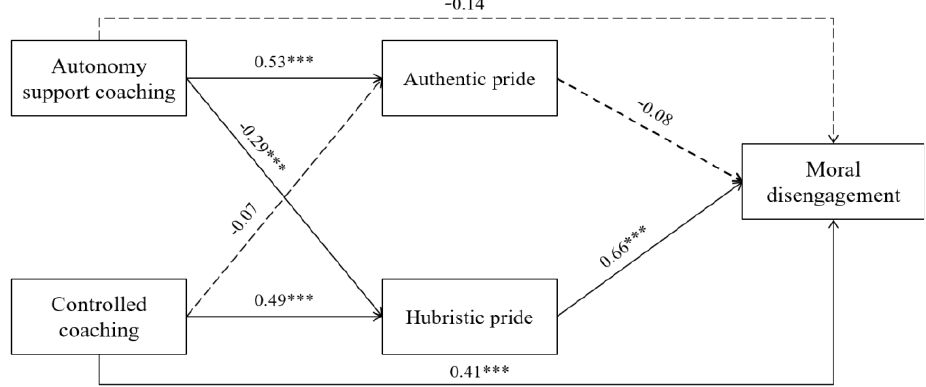
Figure 1. Mediating effect model of pride in the relationship between coaching type and moral disengagement. Note. The values presented in this figure are unstandardized coefficients; The solid line represents significant unstandardized coefficients; dotted line represents non-significant unstandardized coefficients; *** p < 0.001.